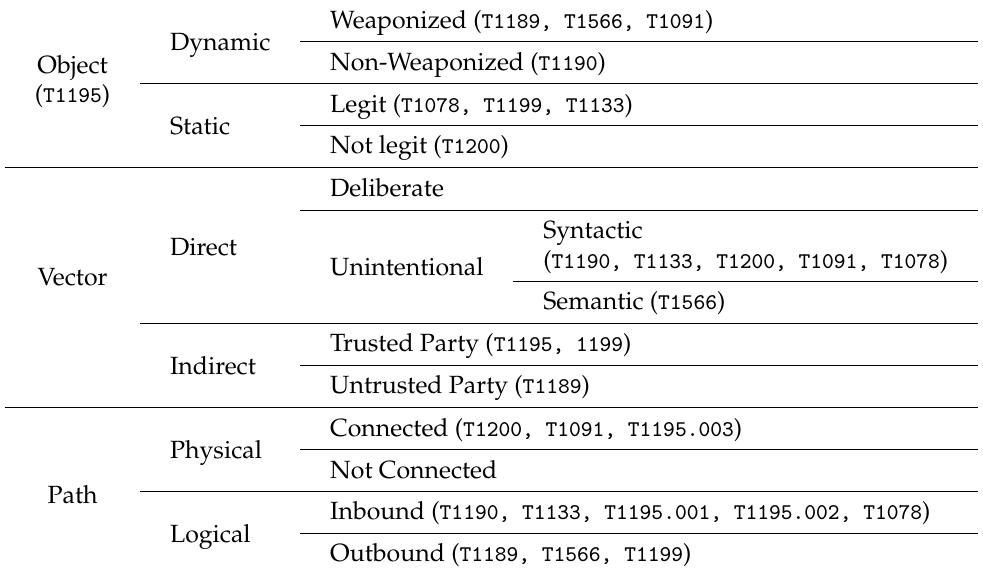
Table 4. MITRE ATT&CK techniques’ classification by threat